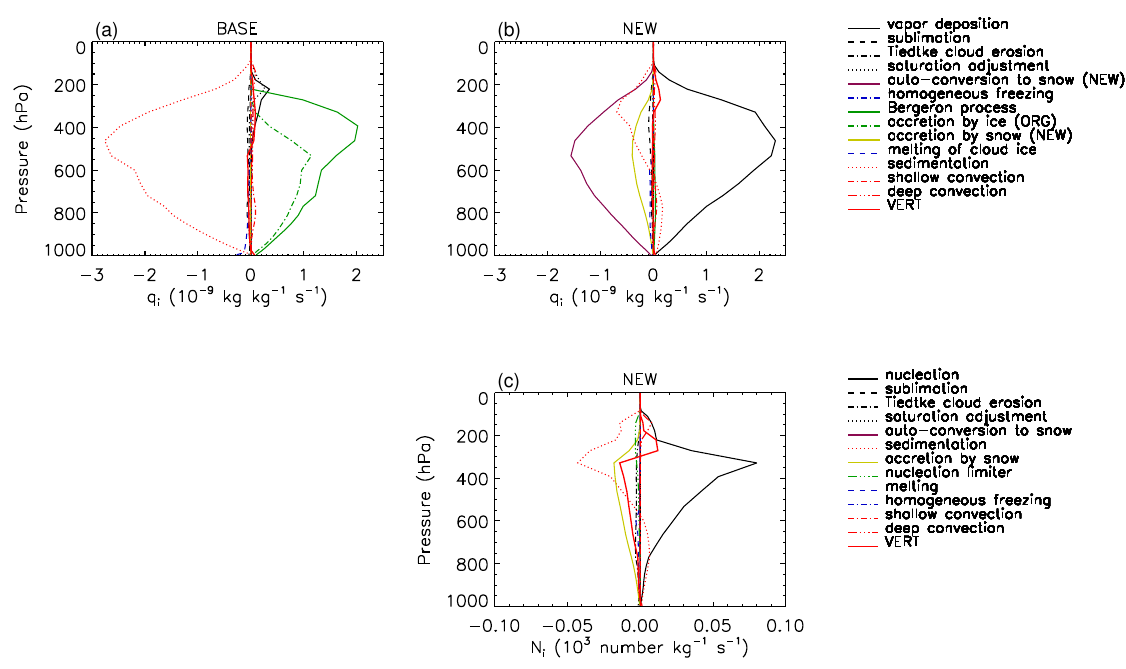
Fig. 11. As Fig. 10 but for ice water amount ( a and b ), and for cloud ice particle number in the NEW run ( c ).